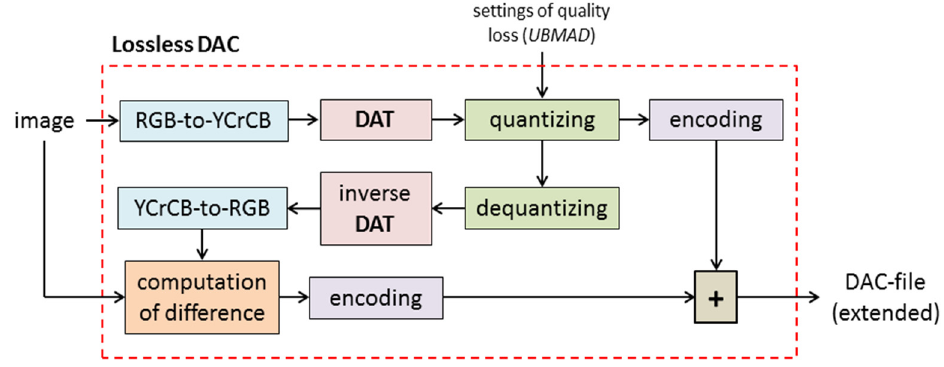
Figure 3. Lossless DAC: compression of the full-color digital image.